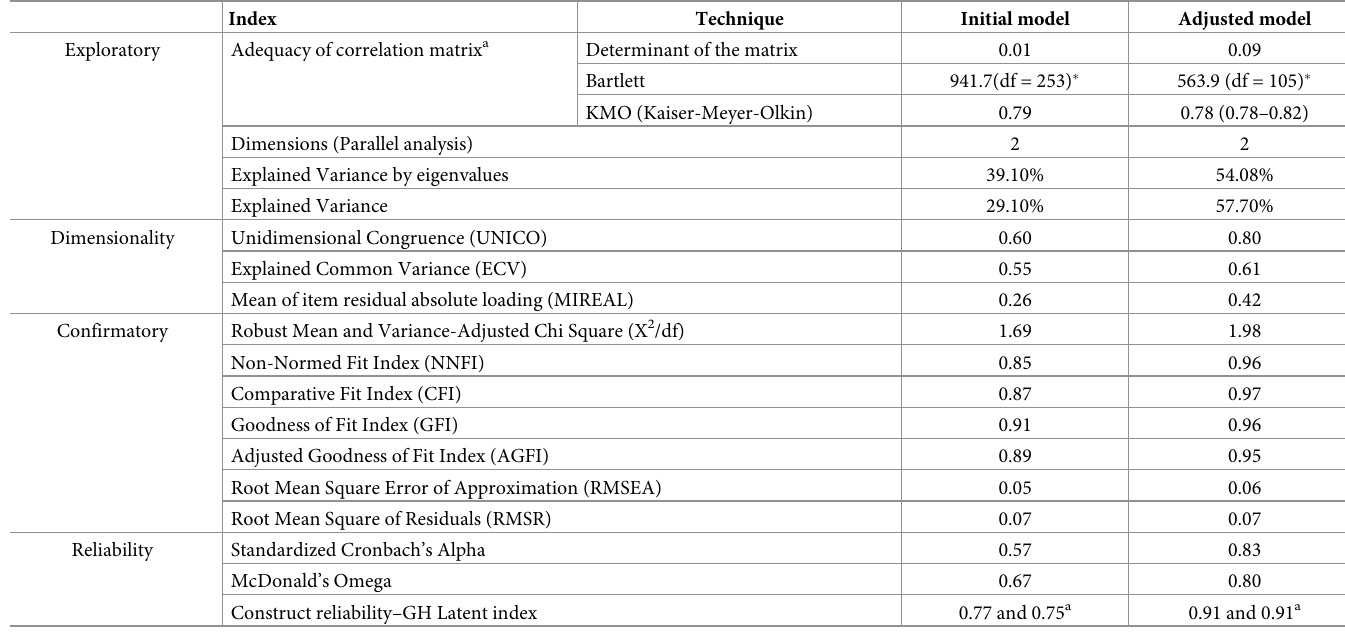
Table 2. Summary of the initial and adjusted model